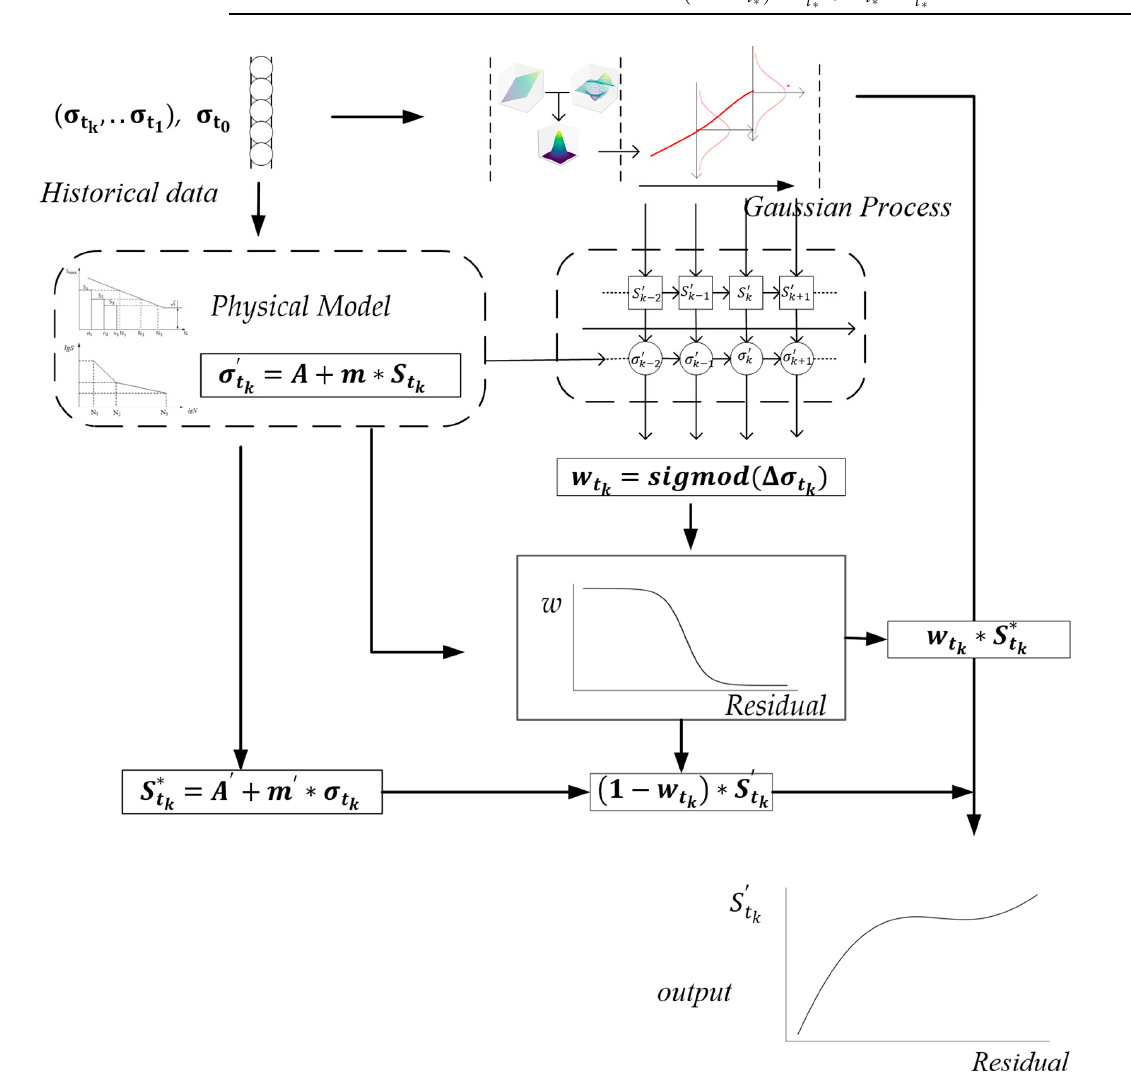
Figure 2. The GP-SS flow chart.